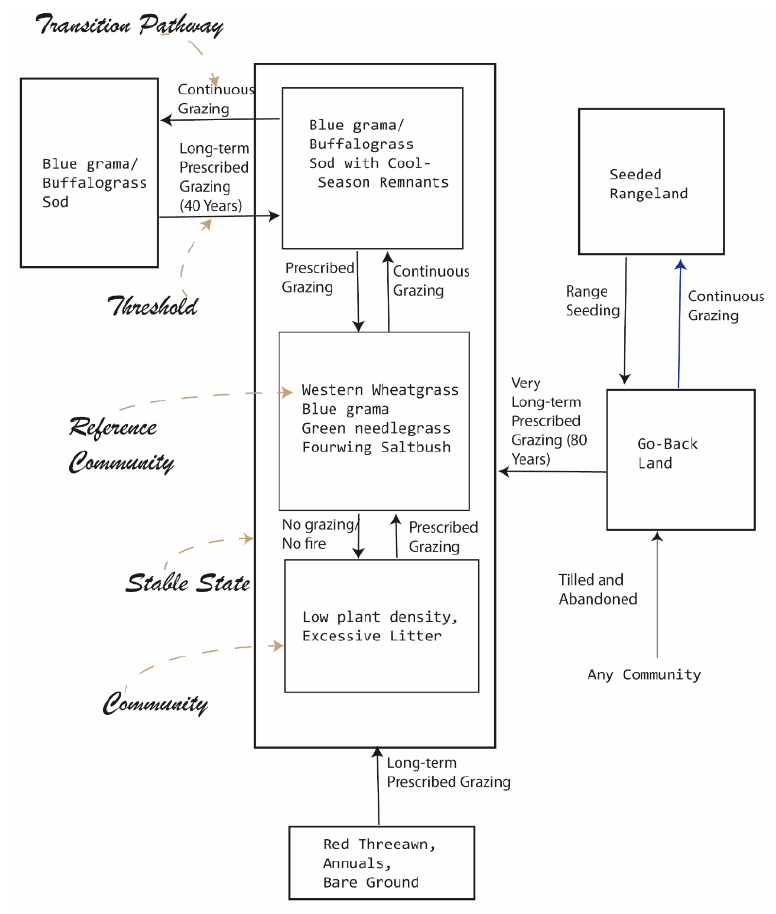
Figure 4. Ecological Site Descriptions (ESDs) are part of a land potential and vegetation classification and mapping system used by US federal land management agencies and private land-owners. ESDs include an estimate of rangeland production and vegetation potential based on specific climate, topography and soil